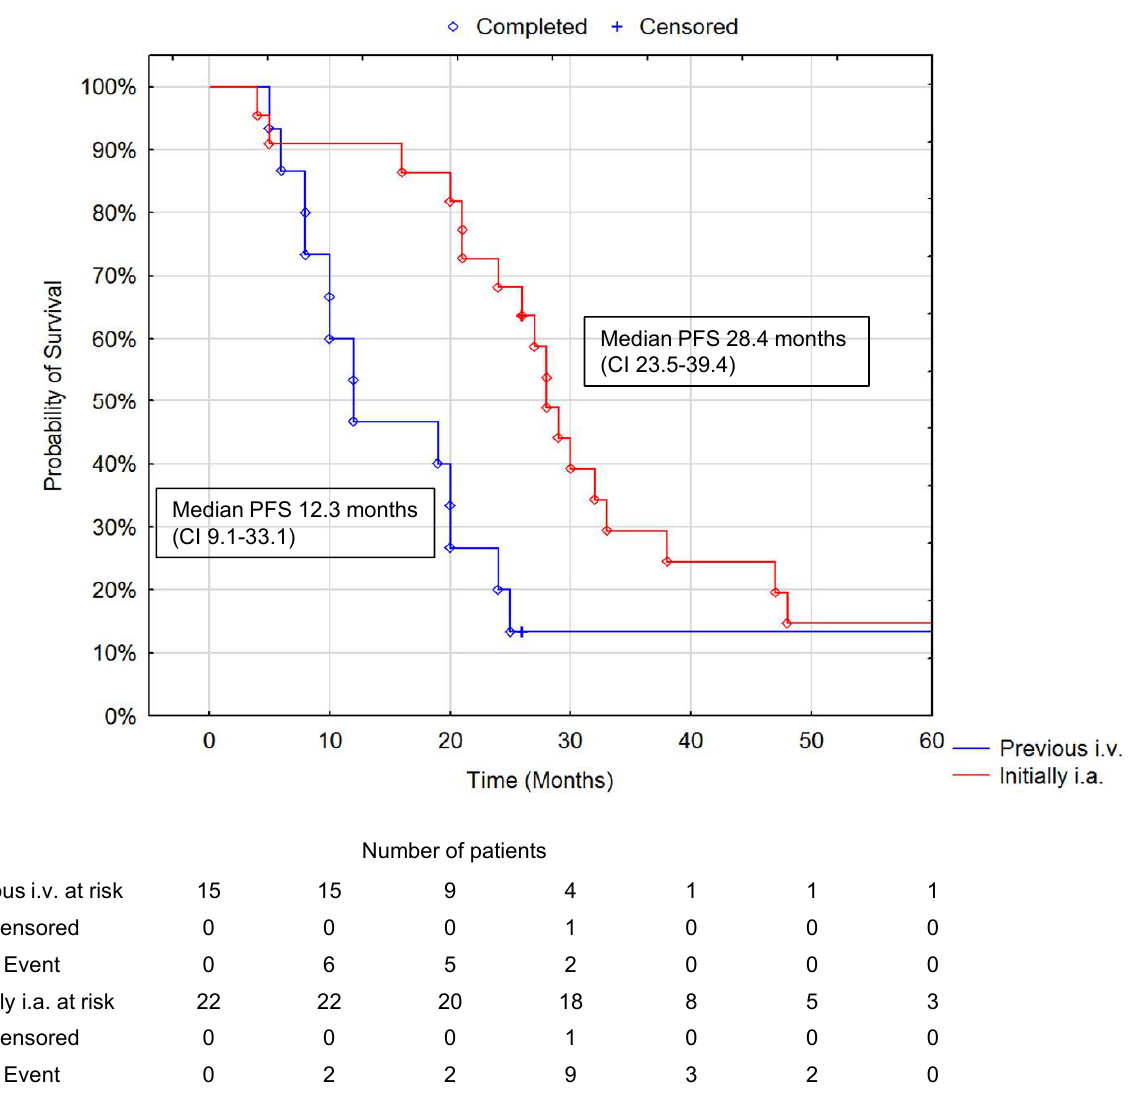
Figure 6. Comparison of PFS in patients with previous i.v. PRRT at 12.3 months (95% CI 9.1–33.1) and initially i.a. PRRT at 28.4 months (95% CI 23.5–39.4) at six months of DCR. ( p = 0.048 Cox–Mantel test). Disease control rate was defined as the proportion of patients with partial response (PR) or stable disease (SD), not patients with complete response (CR). The number of subjects remaining at risk was below 10% of cases in any